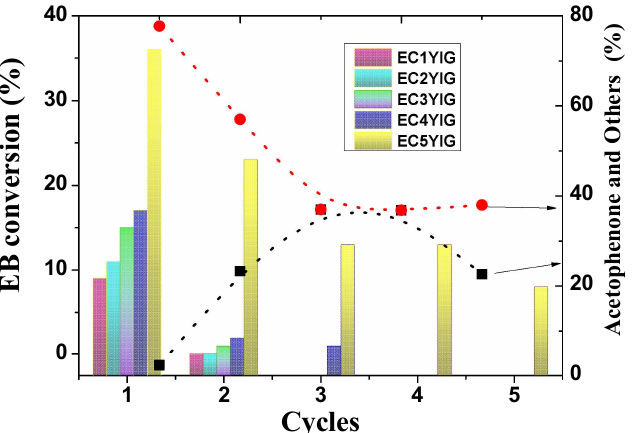
Figure 3. Recyclability of the solids in the EB oxidation in the presence of H 2 O 2 . Reaction conditions: EB to H 2 O 2 molar ratio of 1 using 1.3 mol of acetone as solvent, temperature of 50 °C and a catalyst mass of 50 mg. The symbols (▪) and (•) indicate the selectivity to acetophenone and other products, respectively.